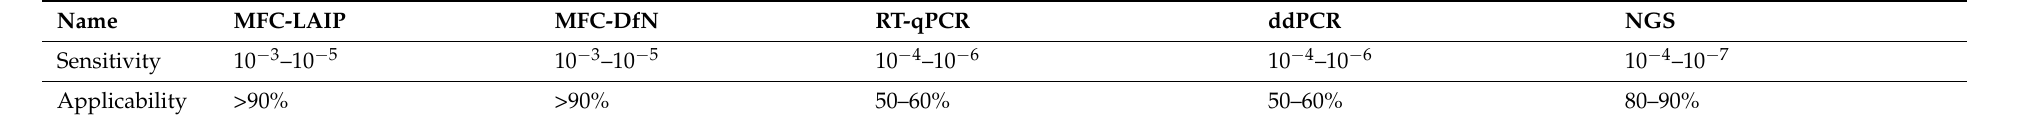
Table 1. Techologies for MRD detection in